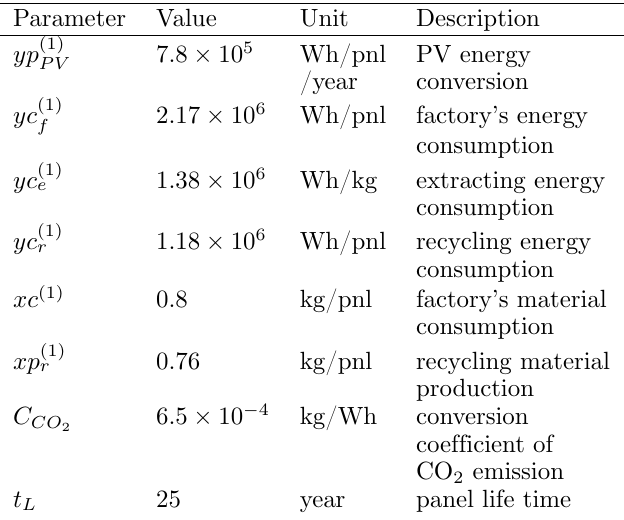
Table 2. Technological parameters of the model. “/pnl” means “per panel".